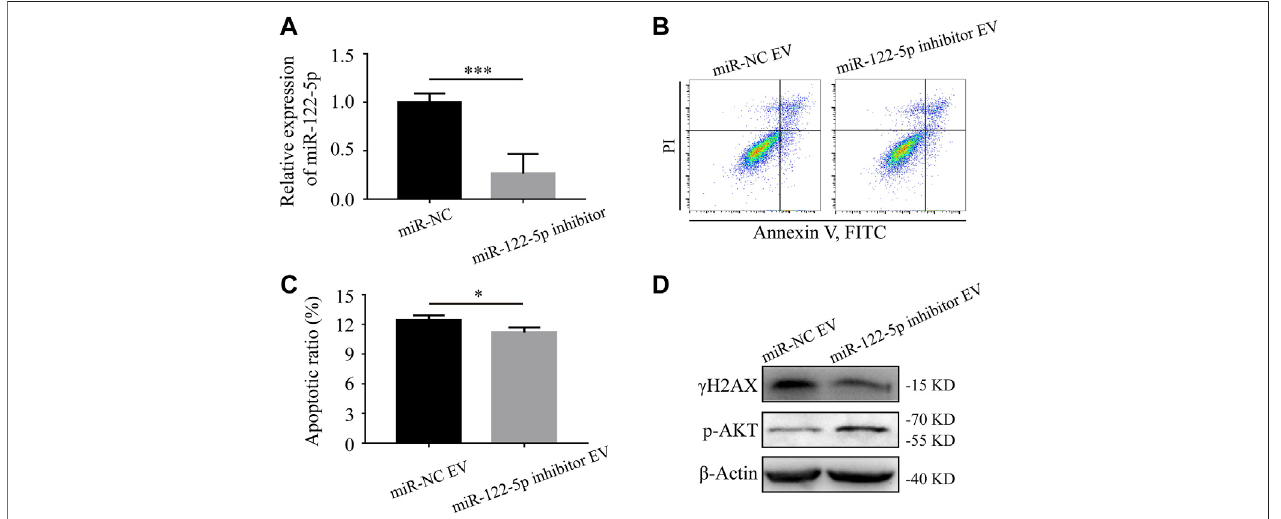
FIGURE 5 | Hypoxic EV-derived miR-122-5p mediates the apoptosis of normoxic HIEC cells. (A) The transfection ef fi ciency of miR-122-5p after 24 h of transfectionwithmiR-122-5pinhibitor.U6wasusedastheendogenouscontrol. (B,C) Flowcytometryinvestigationofapoptosisand (D) Westernblottinganalysisofthe expression of γ H2AX and p-AKT of HIEC cells given the hypoxic EVs from either miR-122-5p inhibitor group or negative control group. ß -Actin was used as the internal control. NC, negative control. ** p < 0.01, *** p < 0.001.